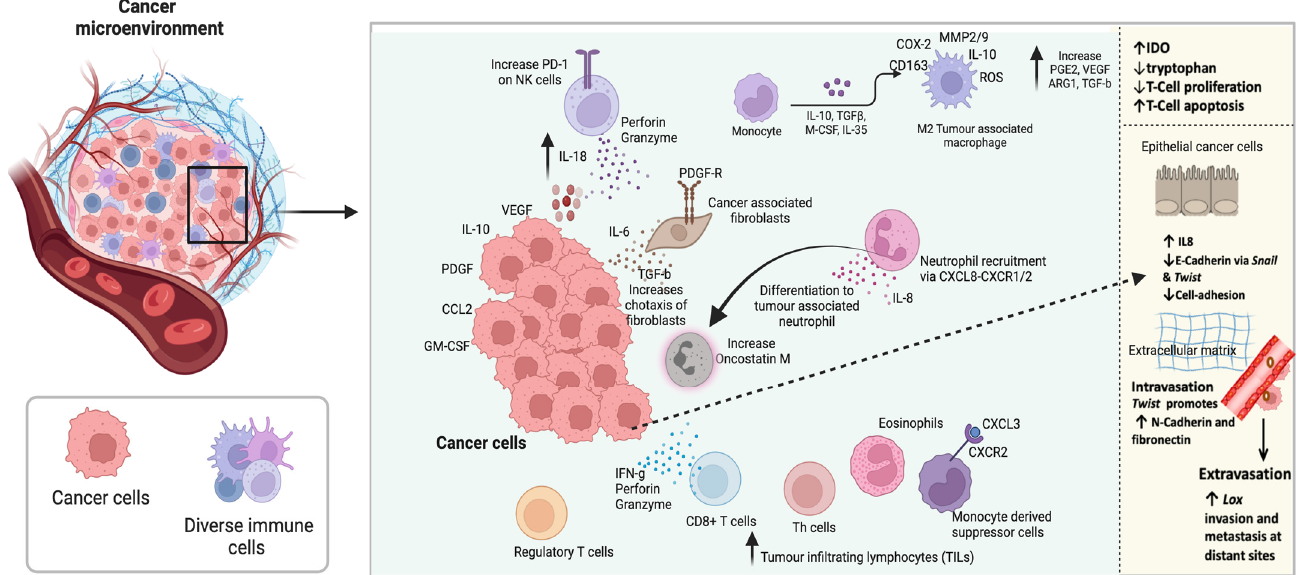
Figure 2. The immunological complexity of the cancer microenvironment. Created using Bioren- der.com. ARG1, arginase 1; CCL2, C-C motif chemokine ligand 2; CD, cluster differentiation; COX-2, cyclooxygenase 2; CXCL3, chemokine (C-X-C motif) ligand 3; CXCR2, C-X-C motif chemokine receptor 2; GM-CSF, granulocyte macrophage colony stimulating factor; IDO, indoleamine-2,3-dioxygenase 1; IL, interleukin; Lox, lysyl oxidase; M-CSF, macrophage colony stimulating factor; MMP2/9, matrix metallopeptidase 2/9; NK, natural killer; PD-1, programmed cell death protein 1; PDE2, phosphodiesterase 2; PDGF, platelet derived growth factor; PD-L1, programmed death lig- and 1; ROS, reactive oxygen species; TGFb, tumour growth factor beta; VEGF, vascular endothelial growth factor.